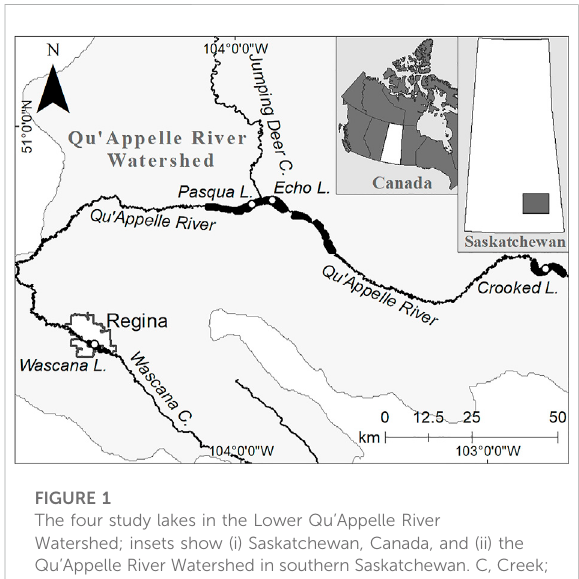
FIGURE 1 The four study lakes in the Lower Qu ’ Appelle River Watershed; insets show (i) Saskatchewan, Canada, and (ii) the Qu ’ Appelle River Watershed in southern Saskatchewan. C, Creek; L, Lake. Map source: Government of Canada open data at